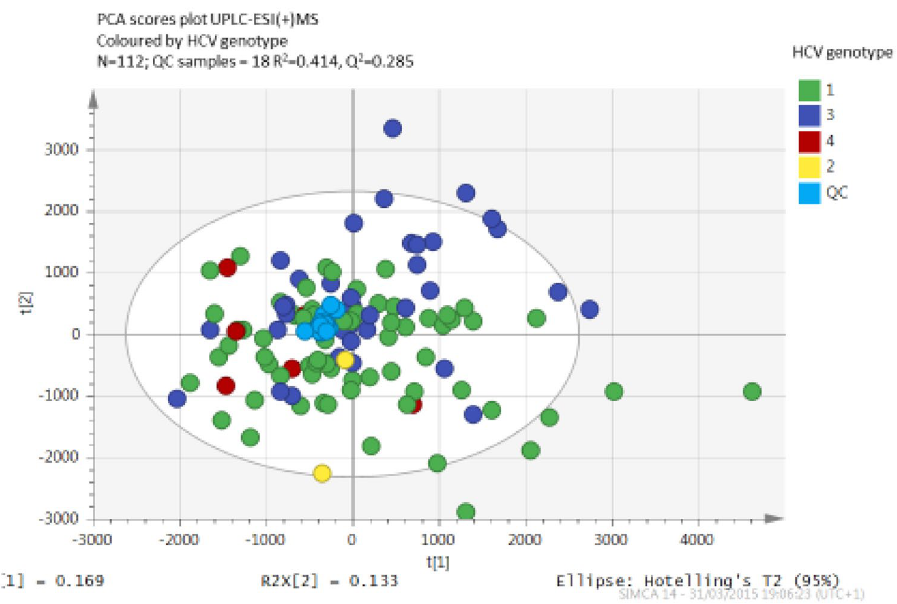
Figure 4. Principal component analysis (PCA) of fasting sera in positive electrospray ionisation mode demonstrating separation between HCV